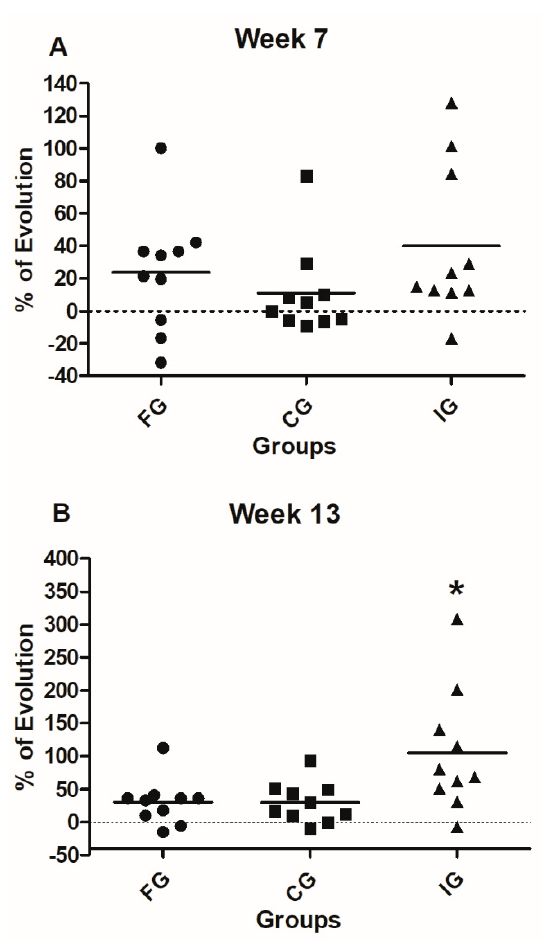
Figure 6. Percentages of evolution (GMFE, walking) of FG, CG, and IG. ( A ) The comparison of the percentages of evolution from the baseline to the seventh week does not show significant improvement in the progress of studied groups. Analysis was performed by using the Kruskal Wallis test. ( B ) The percentage of evolution from the baseline towards the 13th week shows significant improvement of the progress of IG compared to FG and CG patients., * p = 0.029, Kruskal Wallis test. Black line represents the mean of 10 patients.